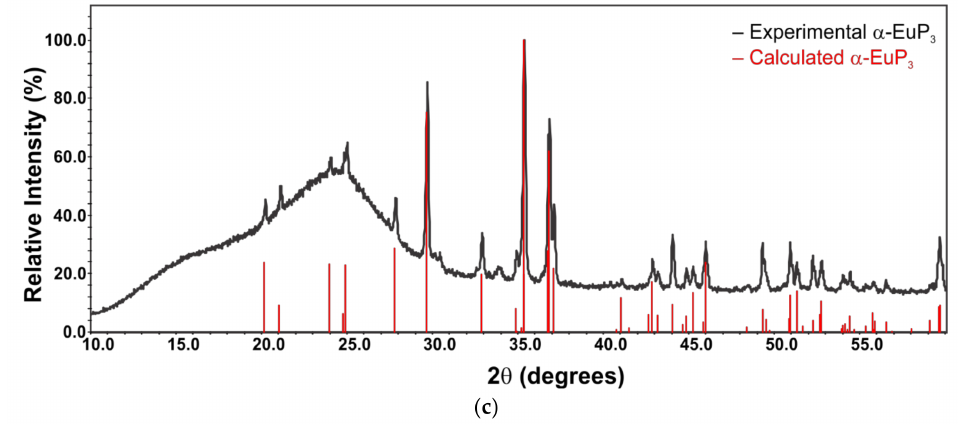
Figure 1. X-ray powder diffraction patterns for EuP 2 ( a ) and EuP 3 ( b and c ) samples along with their calculated patterns from single-crystal data. The high background in the two bottom patterns may be due to the unidentified amorphous admixtures occurring as a result of partial sample decomposition in air. While the target phosphide is the main phase, low-intensity diffraction peaks of unidentified admixtures are